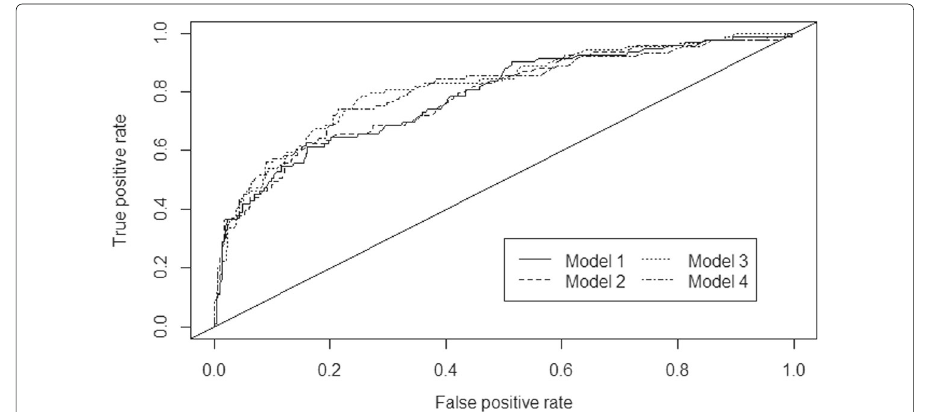
Fig. 2 ROC curves for RF prediction results of the four tested models